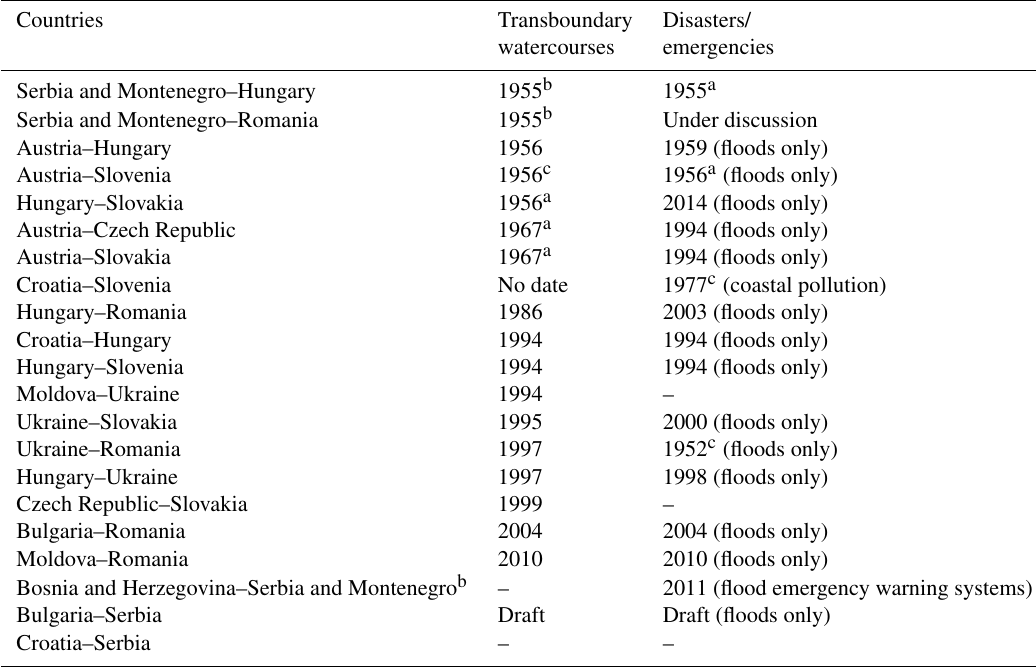
Table 2. List of bilateral agreements within countries in the Danube basin and Tisza sub-basin.